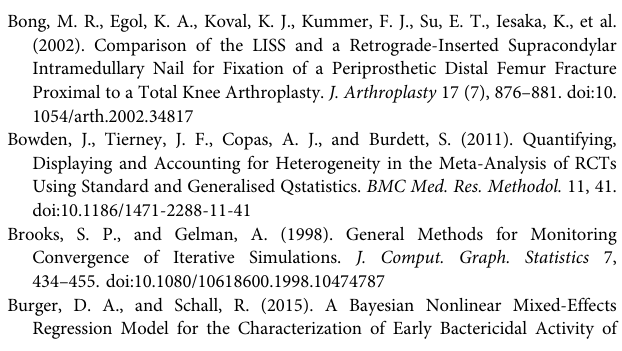
Supplementary Figure S1 | Schematic fi gure for Monte Carlo simulation. Supplementary Figure S2 | Node split plot of major complications and revision rates.